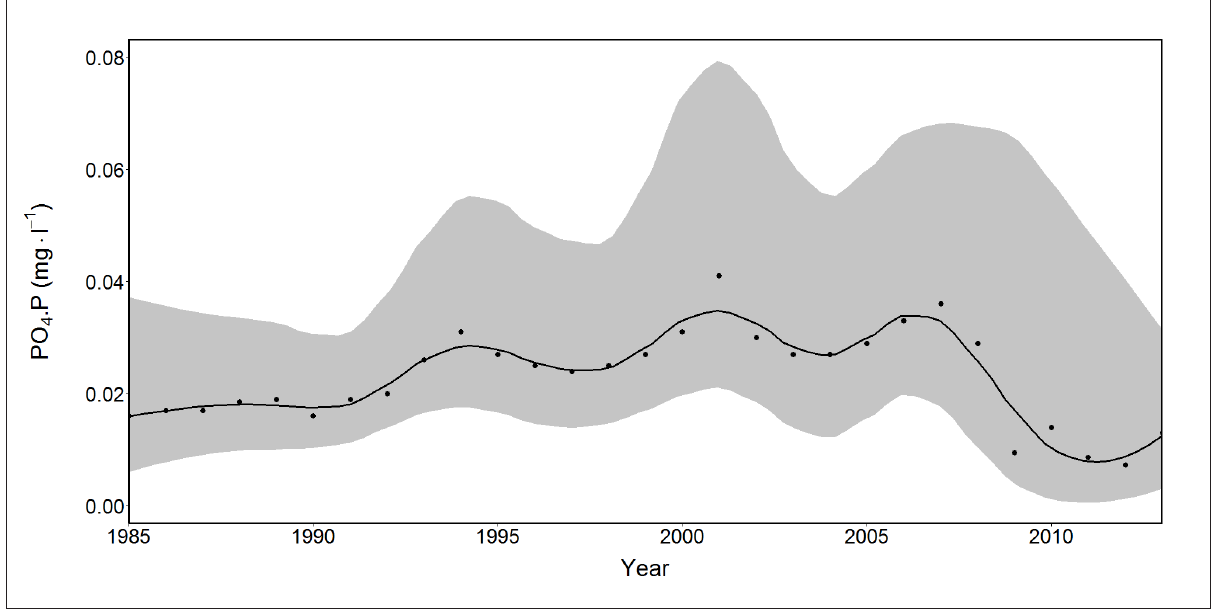
Figure 2: Annual median phosphate levels in South African fresh water plotted against time. The points show median dissolved phosphate (as mg P/L) per year; the line is a loess smoother; and the grey ribbon spans the 25th to 75th